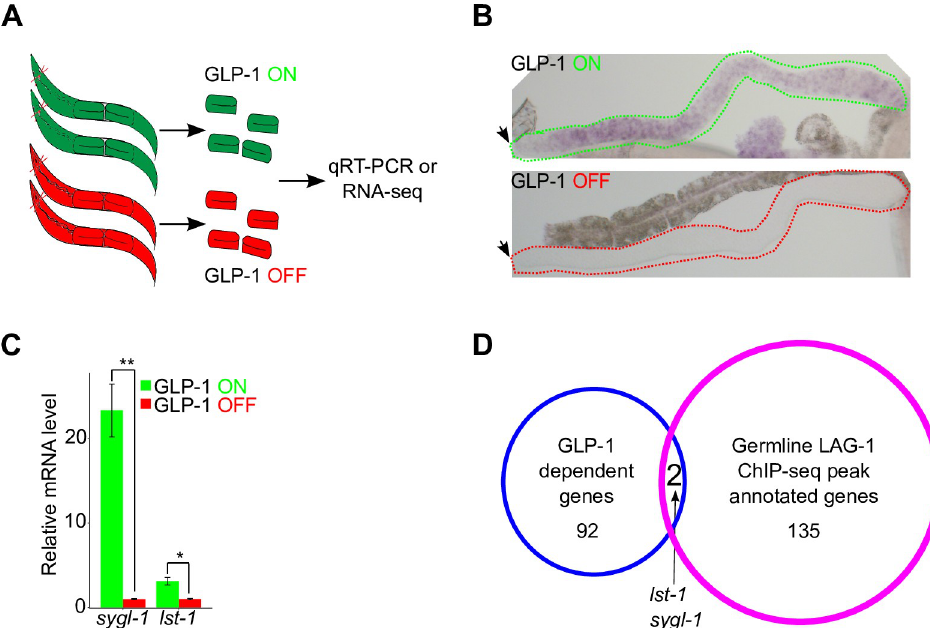
Fig 5. Genome-wide identification of GLP-1-dependent genes by transcriptomic analysis. (A) Schematic showing harvesting of dissected gonads, with tumorous germlines, for either qRT-PCR analysis or transcriptomic analysis. The genotype for GLP-1 ON animal (green) is gld-2(q497) gld-1(q485); glp-1(ar202) and GLP-1 OFF (red) animal is gld-2 (q497) gld-1(q485); glp-1(q175) . (B) In situ hybridization (ISH) used to detect sygl-1 mRNA expression in GLP-1 ON and GLP-1 OFF young adult animals. Dotted lines showing boundary of the gonad. Black arrow indicates distal end of the germline. (C) sygl-1 and lst-1 transcript levels analysis via qRT-PCR. The expression level for each gene in the GLP- 1 OFF background was set as one. Three biological replicates were conducted and two tailed t-test was used for statistical analysis. P-value � 0.01 ( � ); � 0.001 ( �� ). (D) Venn diagram identifying GLP-1 transcriptional targets through integrative genome-wide approach. Five biological replicates were used to conduct transcriptomic analysis and identified 94 GLP-1-dependent genes (blue circle). Two GLP-1 transcriptional targets were defined as genes whose mRNA expression was controlled by GLP-1 and also had LAG-1 bound to their promoter regions (red circle, data from Fig 4D ). See S5 Table